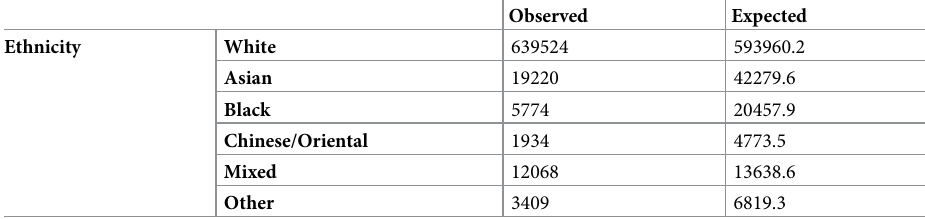
Table 3. Observed and expected frequencies for ethnicity across entire UK (analysed using dataset 2 –April